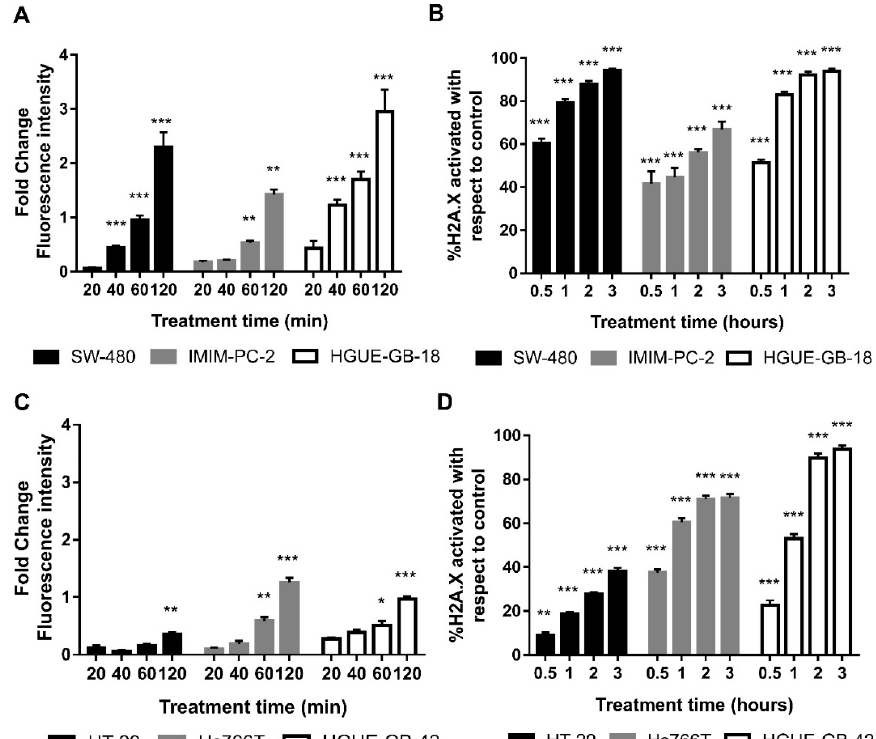
Figure 5. Oxidative damage induced by CLytA-DAAO. ( A ) SW-480 colon carcinoma cell line, IMIM-PC-2 pancreatic adenocarcinoma cell line, and HGUE-GB-18 glioblastoma cell line were treated with 2 U mL − 1 CLytA-DAAO and 1 mM D-Ala for 20, 40, 60, and 120 min. Then, free radical production was determined using 2 ′ ,7 ′ -dichlorodihydrofluorescein diacetate (H 2 DCF-DA). Values represent the fold change of fluorescence intensity compared to control; ( B ) SW-480 colon carcinoma cell line, IMIM-PC-2 pancreatic adenocarcinoma cell line, and HGUE-GB-18 glioblastoma cell line were treated with 2 U mL − 1 CLytA-DAAO and 1 mM D-Ala for 0.5–3 h and then H2A.X phosphorylation was determined by flow cytometry. ( C ) HT-29 colon carcinoma cell line, Hs766T pancreatic adenocarcinoma cell line, and HGUE-GB-42 glioblastoma cell line were treated with 2 U mL − 1 CLytA-DAAO and 1 mM D-Ala for 20, 40, 60, and 120 min. Then, free radical production was determined using H 2 DCF-DA. Values represent the fold change of fluorescence intensity compared to control; ( D ) HT-29 colon carcinoma cell line, Hs766T pancreatic adenocarcinoma cell line, and HGUE-GB-42 glioblastoma cell line were treated with 2 U mL − 1 CLytA-DAAO and 1 mM D-Ala for 0.5–3 h and then H2A.X phosphorylation was determined by flow cytometry Data represent the mean ± SEM of the percentage of cells, with n ≥ 3. * indicates p < 0.05, ** p < 0.01, and *** p < 0.001.